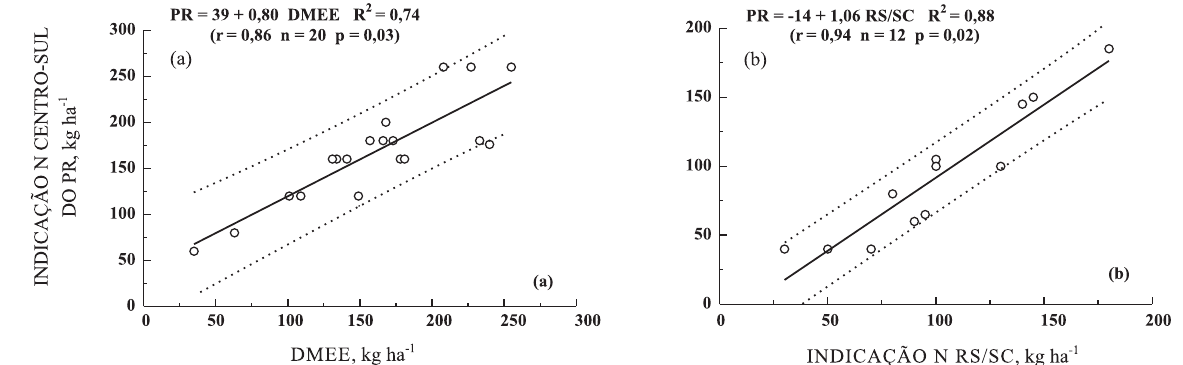
Figura 7. Relação entre as doses de máxima eficiência econômica (DMEE) de N as doses indicadas no quadro 1 (a), e entre a indicação de N do RS/SC e a indicação para a região centro-sul do PR (Quadro 2) para condições similares de solo, cultura antecessora e faixa de rendimento (b). As linhas tracejadas representam o intervalo de confiança de 95 % da equação